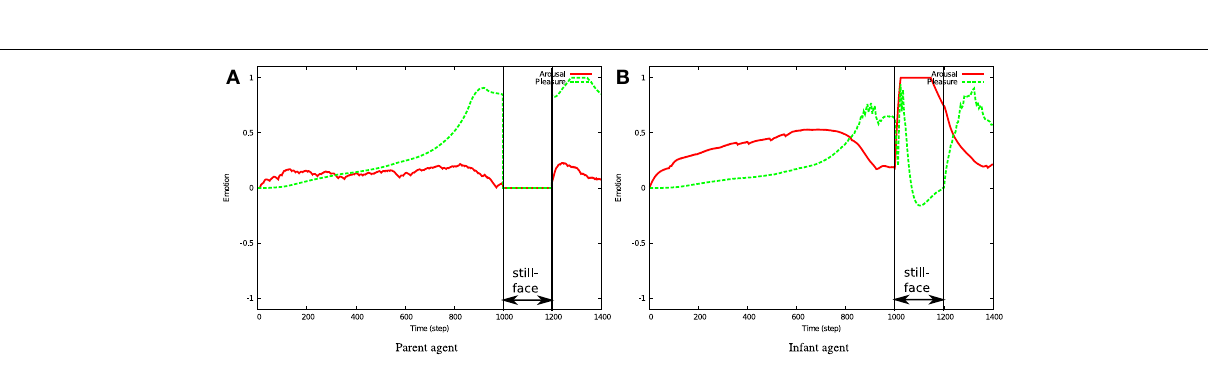
FIGURE 10 | Relatedness during simulated parent–infant interactions. (A) Relatedness of infant agent. (B) Relatedness of parent agent.